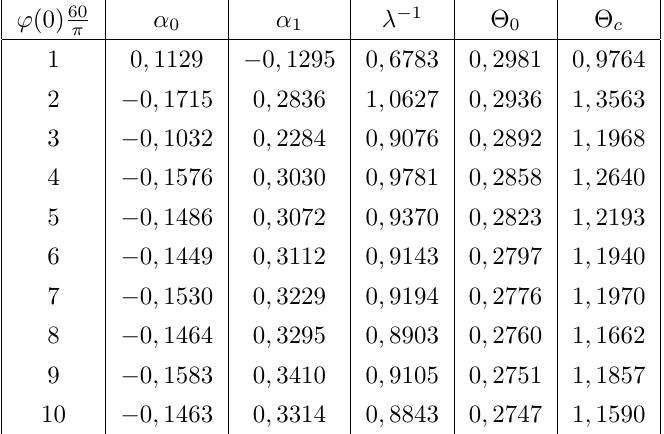
Table 6 . Length parameters for